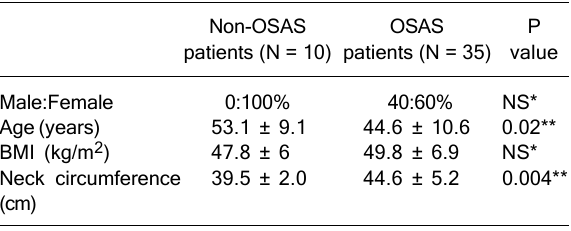
Table 1. Clinical aspects of class III obese non-OSAS and OSAS